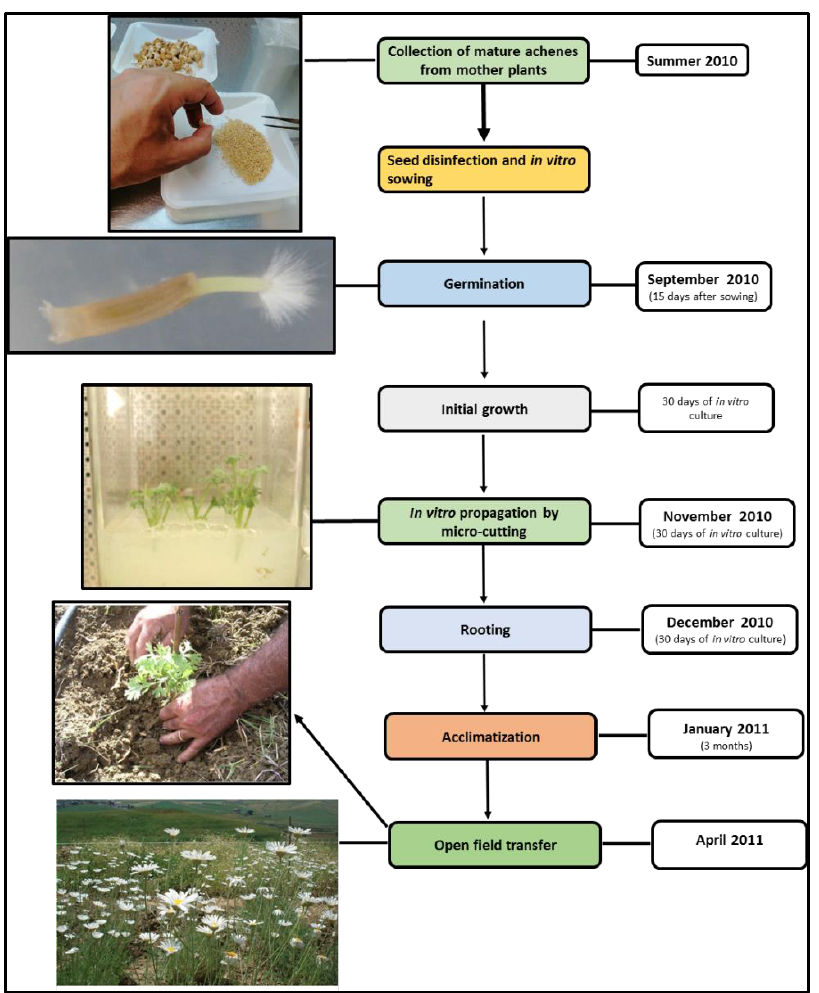
Figure 1. In vitro propagation of pyrethrum: flow chart .